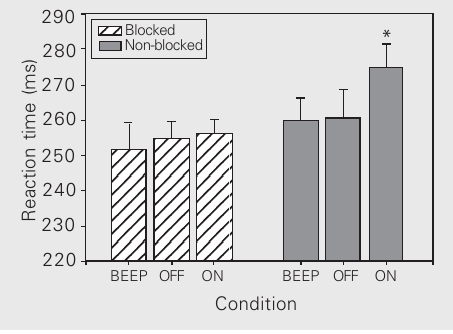
Figure 2. Mean latency of manual reaction times (ms) as a function of interval (ms) and condition (BEEP, OFF and ON) for the two contexts: A , blocked context; B , non-blocked con- text. The error bars indicate ± SEM. Planned comparisons showed that in the non-blocked context reaction times for the ON condition were longer than those obtained for the OFF con- dition at the intervals of 0 and 250 ms (*P <